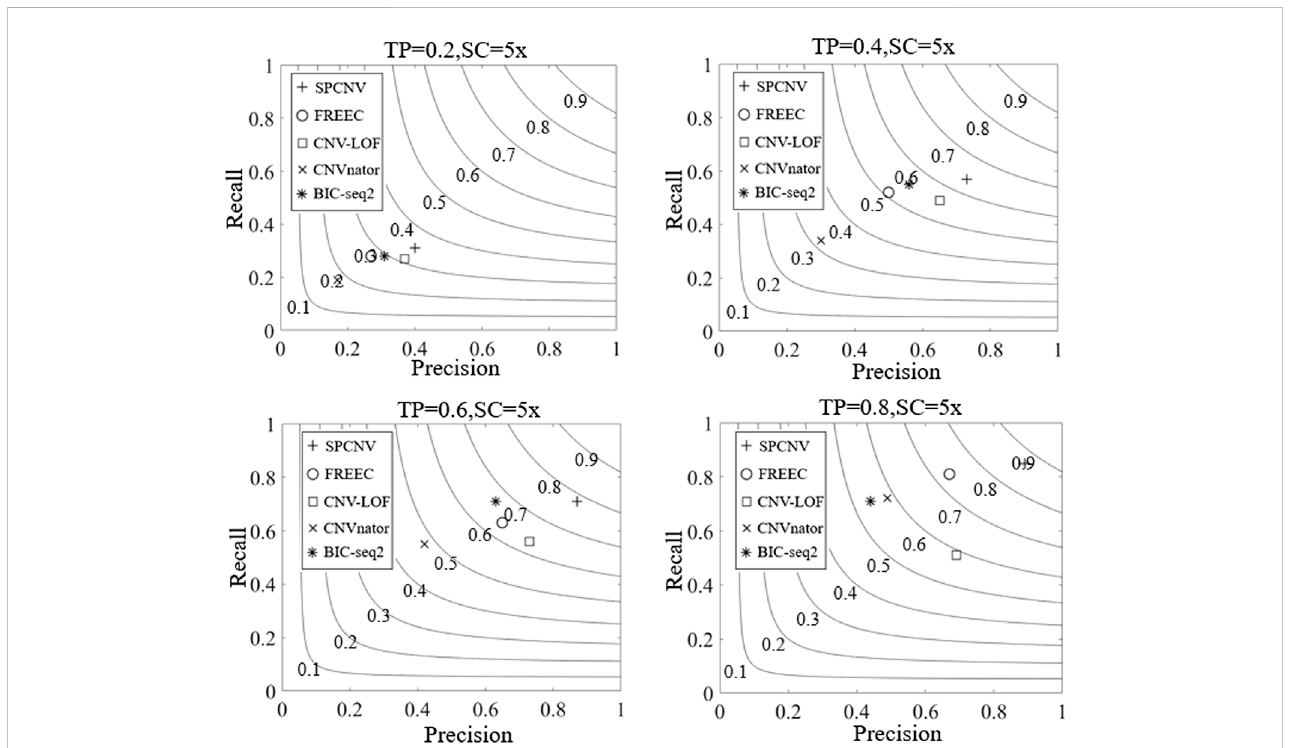
FIGURE 3 Theperformanceofthe fi vemethodsiscomparedintermsofrecall,precision,andF1-scoreacrossfoursetsofsimulationsamples.Blackcurvesindicate that the F1-score levels are harmonic means of recall and precision ranging from 0.1 to 0.9. The equations on the left and right sides of the comma represent the tumor purity (TP) and sequencing coverage (SC), respectively.